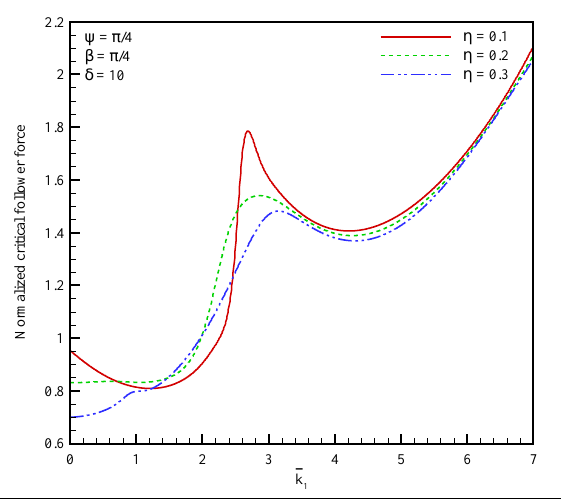
Figure 15. Normalized critical follower forces ( f cr The time domain response of the beam to a follower force excitation was investigated